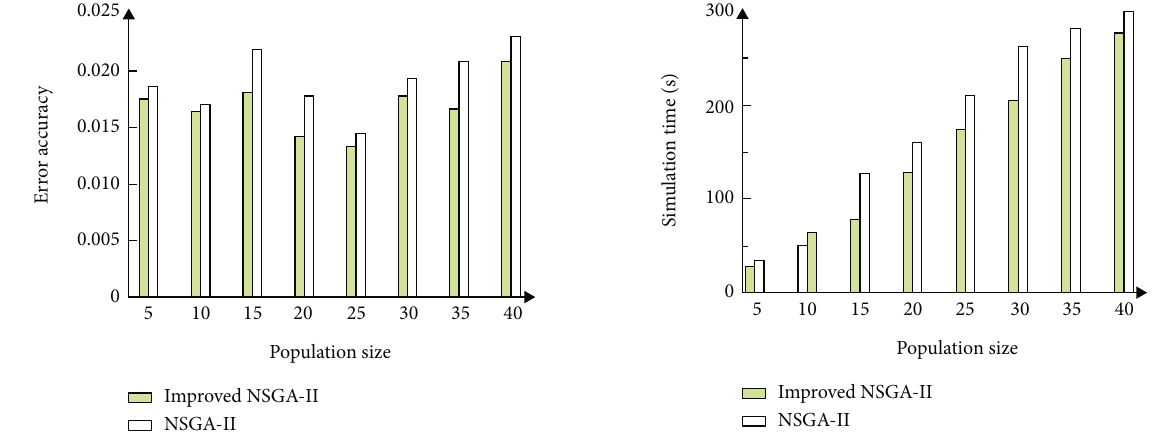
(b) Variation of the algorithm simulation time with the population size Figure 8: Changes in the performance of the improved NSGA-II algorithm with the population